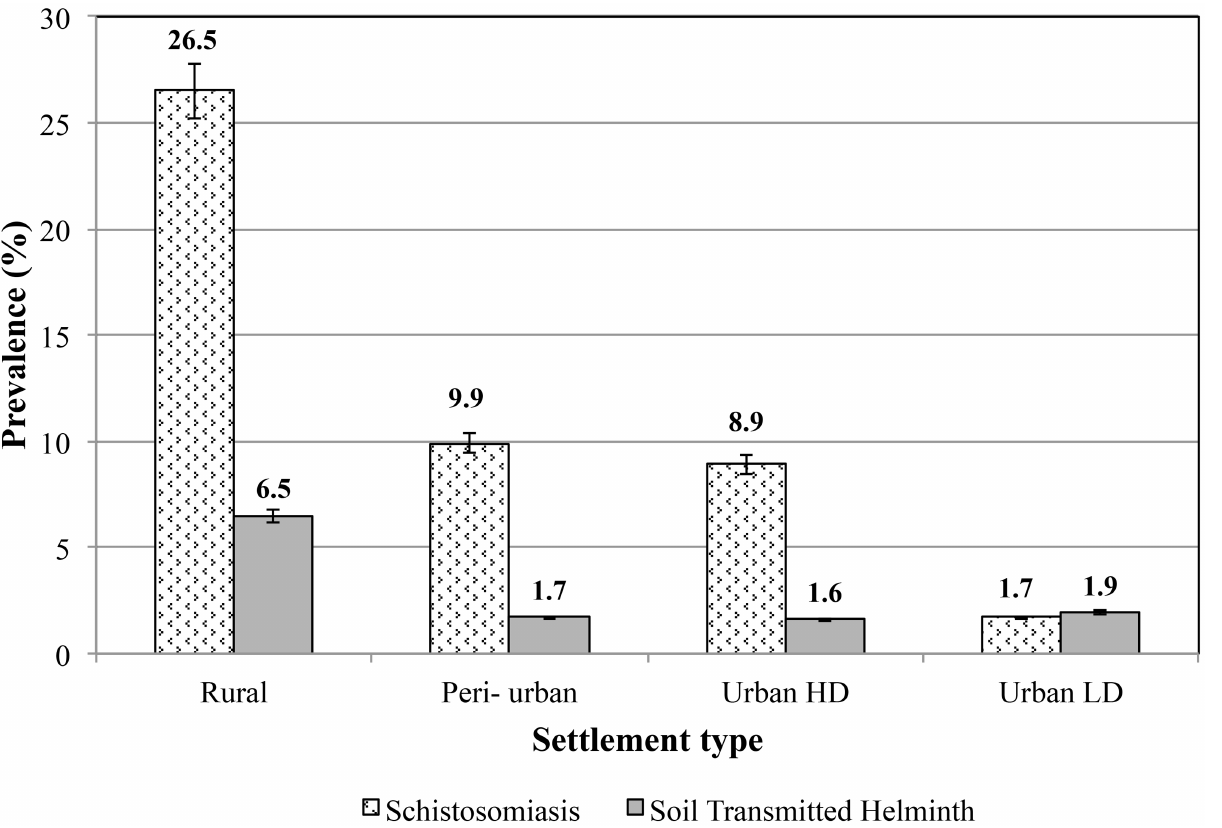
Figure 1. Prevalence distribution of schistosomiasis and STH among 13, 038 primary school children by settlement in Zimbabwe during 2011 school calendar. (HD = High density; LD = Low density) doi:10.1371/journal.pntd.0003014.g001 PLOS Neglected Tropical Diseases |